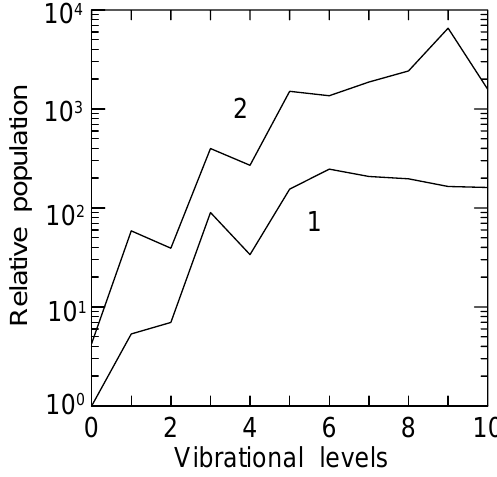
Fig. 13. The same as in Fig. 11, but for the A 3 6 + u state: 1 and 2 – without and with the contribution of the process Fig.13.